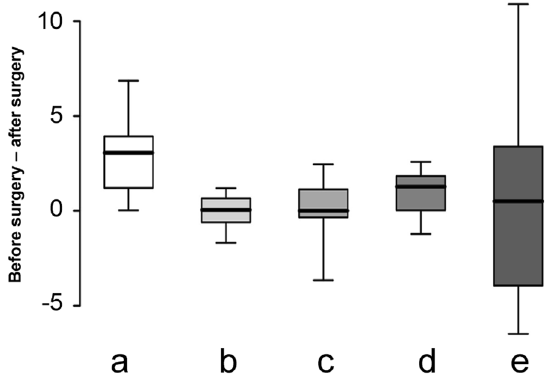
Fig. 8 Box plot of various surgical outcomes pre- and postoperatively. a dental midline; b mandibular width c occlusion, d anterior mandibular length, e angle between mandibular